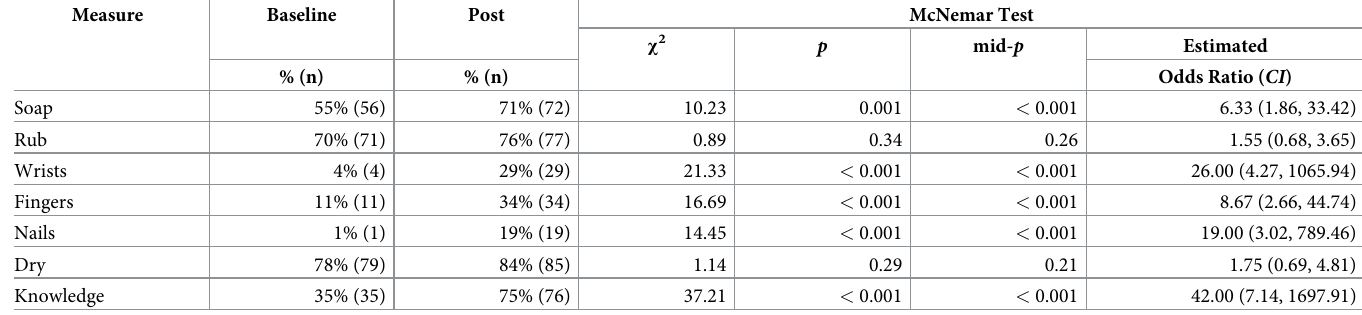
Table 2. Study 1 baseline vs. post intervention: Percentages of participants in the intervention group (n = 101) who demonstrated each handwashing behaviour and whose responses included “germs”. Measure